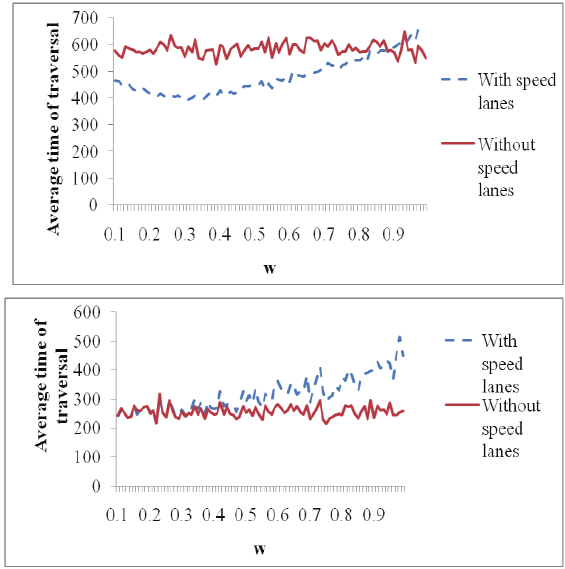
Fig. 4.Comparative analysis of speed lane system for different values of w (a) Densely occupied scenario (b) Lightly occupied scenario.